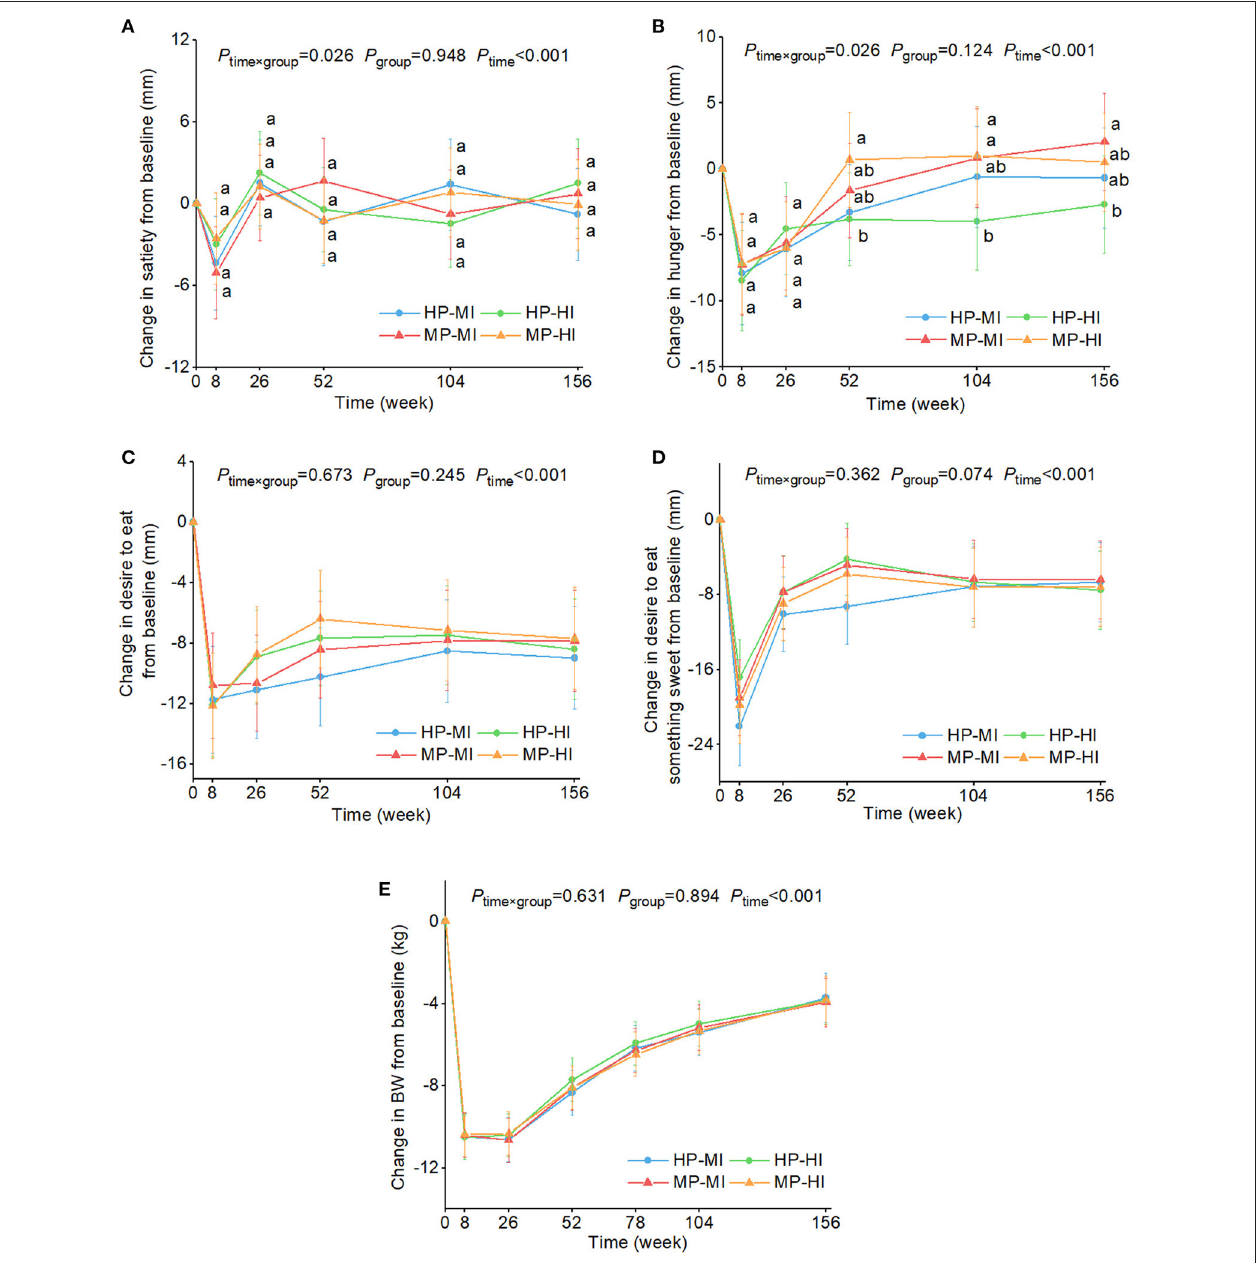
FIGURE 4 | Estimated marginal means and 95% CI in changes in ratings of satiety (A) , hunger (B) , desire to eat (C) , and desire to eat something sweet (D) , and body weight (E) over time by four intervention groups. Analyses were performed using a linear mixed model with repeated measures adjusted for age, sex, ethnicity, baseline appetite ratings (0 weeks), and time as fixed effects and participant-ID and intervention center as random effects. Time × group or group × sex or group × age interaction terms were added. If the interaction was significant, post hoc multiple comparisons with Bonferroni correction were conducted at each time point. Values with the different lowercase letters were significantly different, P < 0.05. No group × sex or group × age interaction was observed. BW, body weight; HP-MI, high protein-low glycemic index diet, moderate intensity physical activity; HP-HI, high protein-low glycemic index diet, high intensity physical activity; MP-MI, moderate protein-moderate glycemic index diet, moderate intensity physical activity; MP-HI, moderate protein-moderate glycemic index diet, high intensity physical activity.